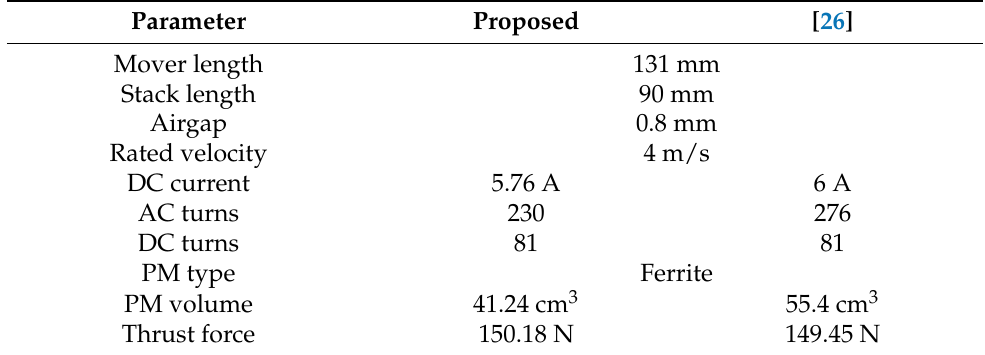
Table 9. Comparison of proposed and conventional